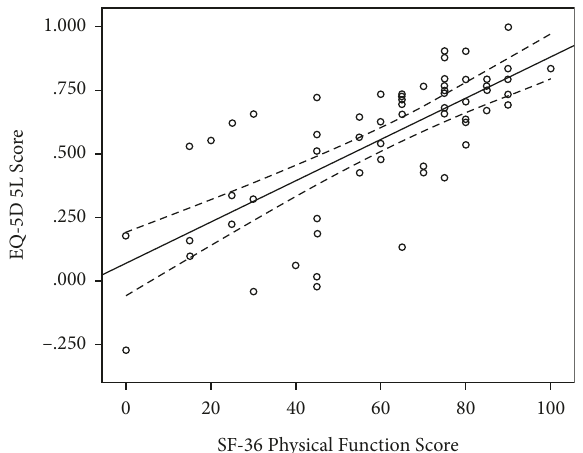
Figure 3: Scatter plot of physical function dimension of the SF-36 score and EQ-5D with the linear line of best fit (solid black line) and the 95% confidence intervals around the mean (dashed